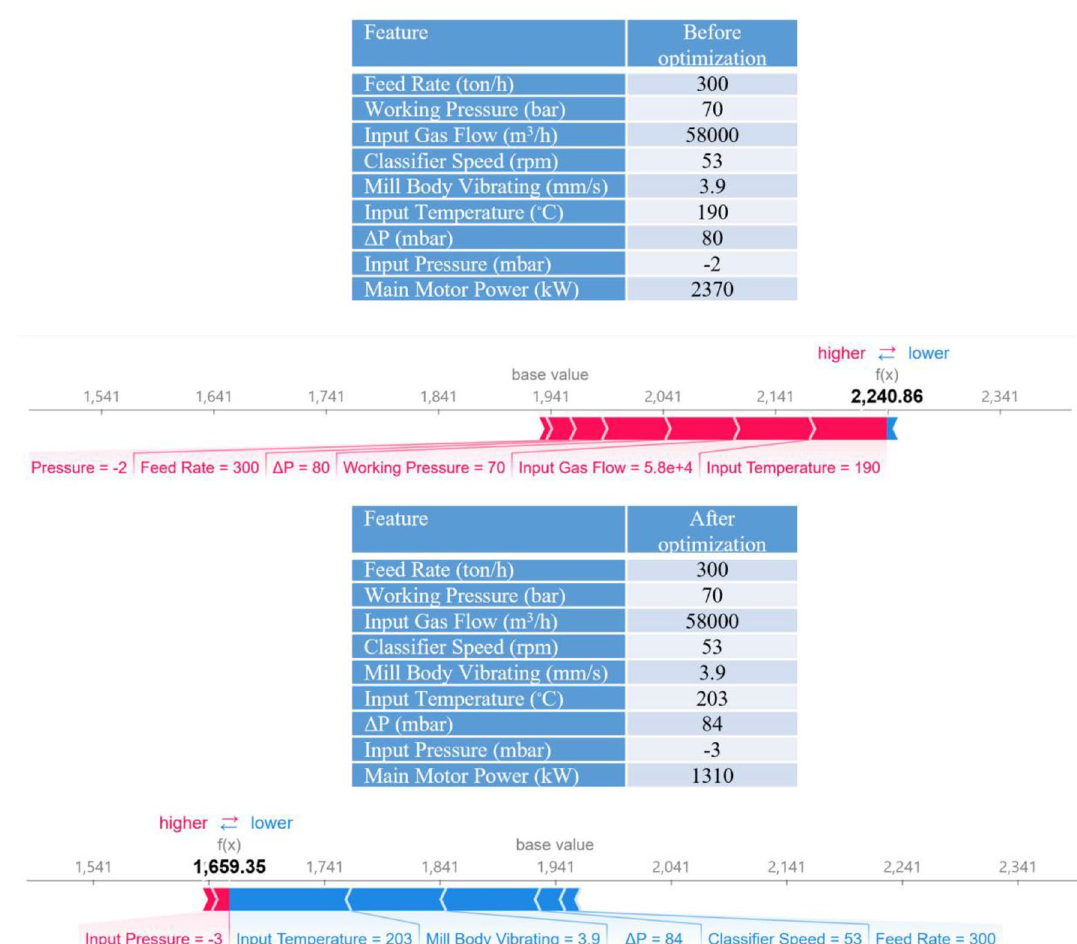
Figure 7. Possible optimization for the motor power consumption based on the SHAP results.